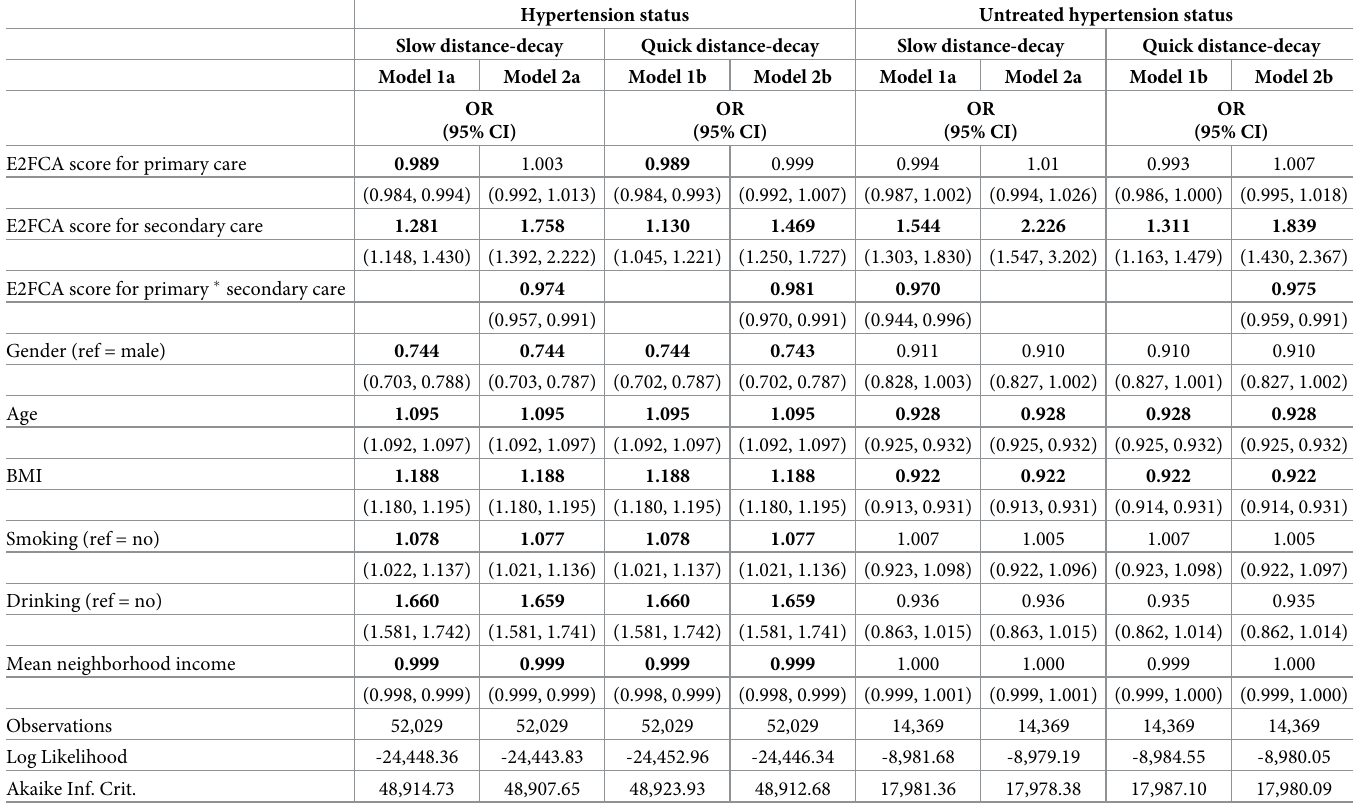
Table 3. Multivariable logistic regression for hypertension and untreated hypertension status by primary and secondary care accessibility.